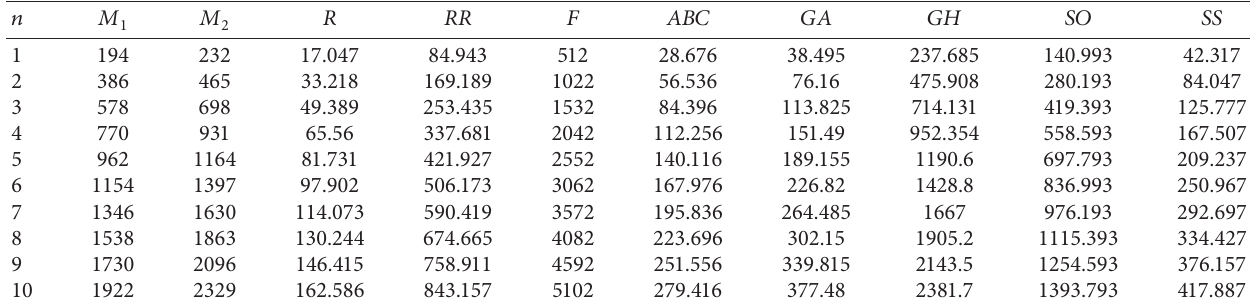
Table 5: Numerical representation of the computed indices for HPG and